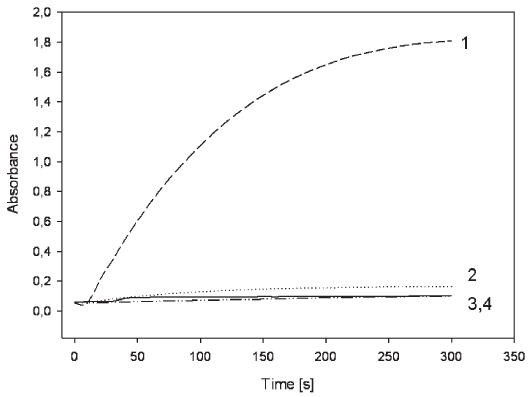
Figure 2. Absorbance changes at 417 nm, of the color product of ABTS oxidation catalyzed by DNAzyme based on: PS2.M (1), Tel2 (2), Tel1 (3), and hemin itself (4).